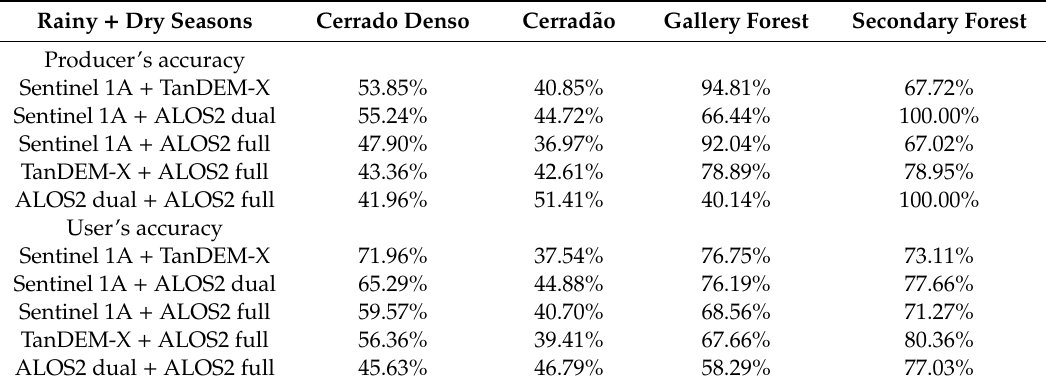
Table 7. Producer’s and user’s accuracy of classifications based only on combinations of SAR sensors for the four Cerrado types. All data acquisitions during the dry and rainy seasons were considered. Rainy + Dry Seasons Cerrado Denso Cerrad ã o Gallery